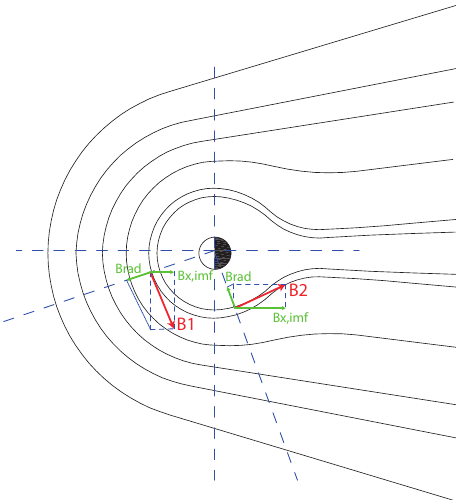
Figure 12. Magnetic field draping around a comet and field projec- Fig.12. Magneticfielddrapingaroundacometandfieldprojectionsattwodifferentlocationsshowingthatthe tions at two different locations showing that the radial projection of radialprojectionofthedrapedmagneticfieldchangesdirectionfor“over-draped”fieldlines. the draped magnetic field changes direction for “over-draped” field Fig.11. Toppanel: ThemagneticfielddatafromGiottowiththetenintervalsforwhichfieldlinedrapingwas Figure 11. Top panel: the magnetic field data from Giotto with studiesmarkedingray. Thereddottedlinesshowtheboundariesbetweendifferentlydrapedfieldasdetermined the 10 intervals for which field line draping was studies marked in byRaederetal.(1987). Bottompanels: Fieldlinedrapingfits,accordingtoEg.(3)forthreeintervals: a“bad” gray. The red dotted lines show the boundaries between differently fitwith ;a“peculiar”fitwithpositiveslope A anda“good”fitwith rc . | rc | ≤ 0 . 8 ≥ 0 . 8 draped field as determined by Raeder et al. (1987). Bottom panels: field line draping fits, according to Eq. (3) for three intervals: a bad fit with | rc | ≤ 0 . 8; a peculiar fit with positive slope A and a good fit with rc ≥ 0 . 8.